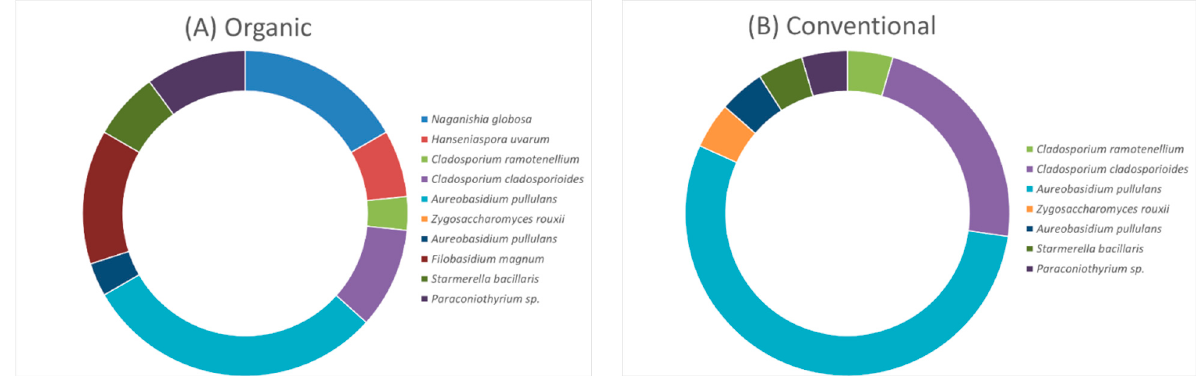
Figure 5. Distribution of fungal profiles recovered from all samples (grape and bark) at different sampling times, plotted according to vineyard agronomic management: ( A ) Organic (26 sequences); ( B ) Conventional (26 sequences). Table 2. Biodiversity indices calculated on individuals belonging to different genetic profiles within each group.